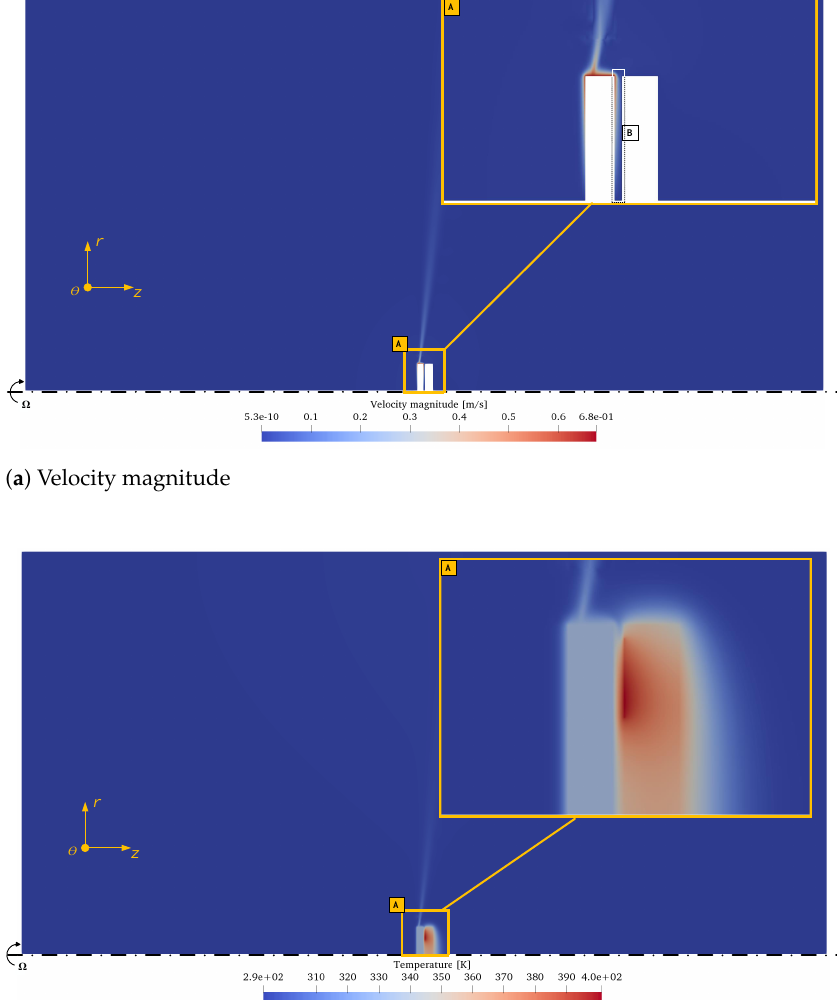
Figure 12. ( a ) Velocity and ( b ) temperature distribution computed by the coupled model on the AFPM domain for Re = 5513 and d = 10.0 mm. Zoom A , corresponds to an enlargement of the area of interest, clearly showing the velocity stream and heated core at the stator